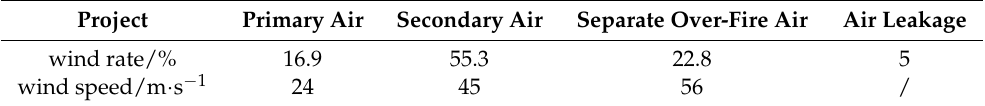
Table 3. Wind rate and wind speed